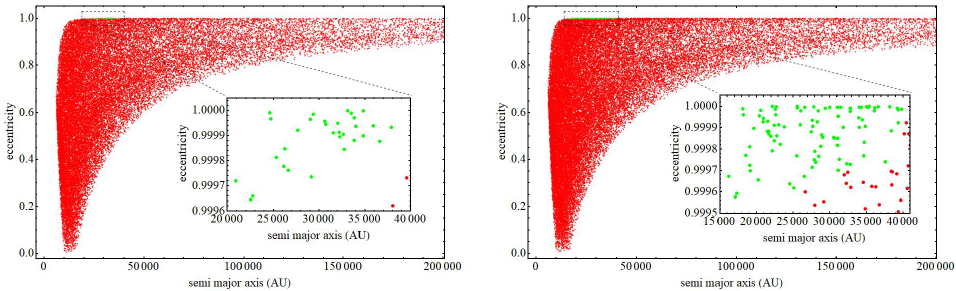
Figure 4. The eccentricity versus the semi major axis plots of the comets constructed in the Monte Carlo simulations for velocity perturbation magnitude in the range between 0.1 and 0.14. The red points correspond to the comets whose elliptic trajectories remain outside the planetary region after the velocity perturbation, whereas the green points correspond to those that enter the planetary region after the velocity perturbation. Left panel: The perturbed comet orbit parameters before the gravitational transition. Right panel: The perturbed comet orbit parameters after the gravitational transition has occurred, increasing the gravitational strength µ by 10%. Notice the significant increase in the number of comets that enter the solar system.